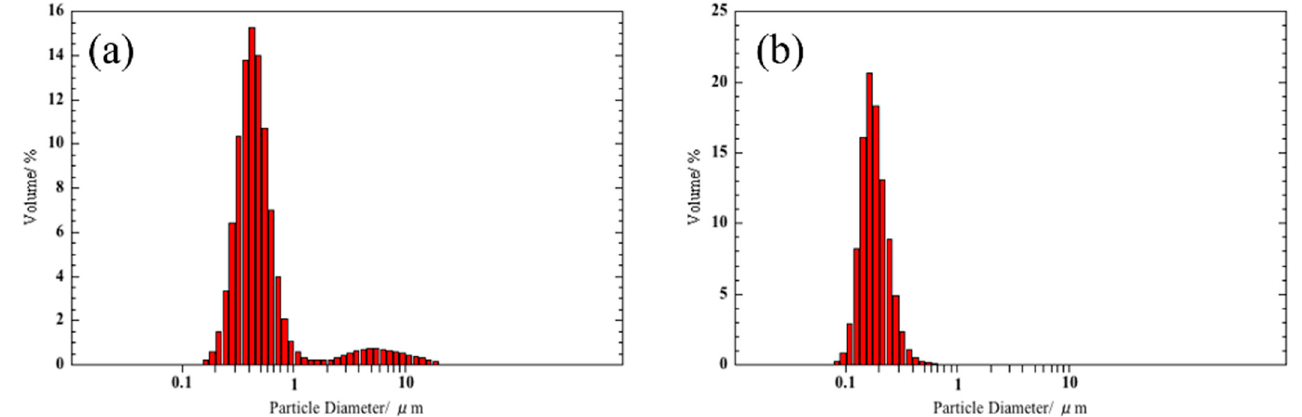
Figure 3. Volume distribution of the classified SmFeO 3 powders: ( a ) as balled milled (sample A), and ( b ) the supernatant component of the suspension of sample A (sample B).